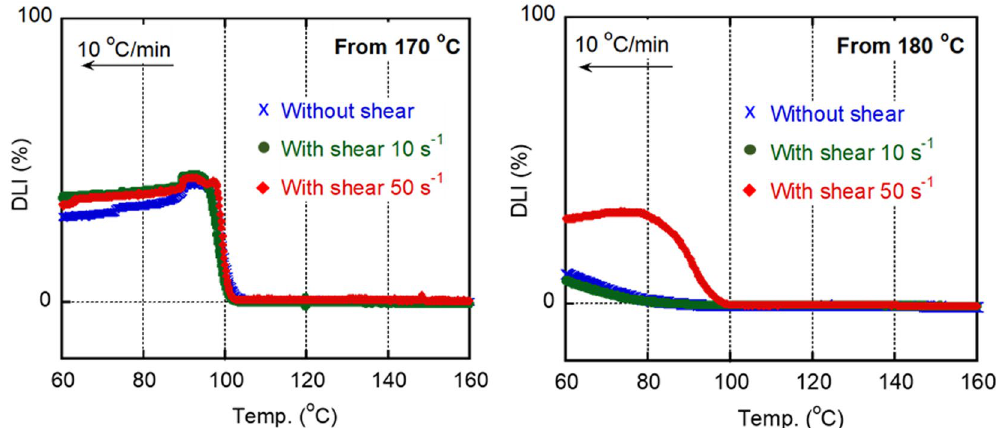
Figure 6. Growth curves of depolarized light intensity (DLI) with/without applied shear history during cooling at 10 °C min −1 . The shear history was applied from 170 °C (left) and 180 °C (right) to 130 °C at 10 and 50 s −1